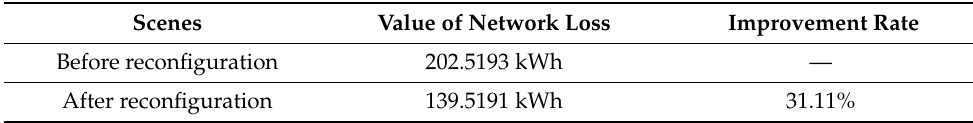
Table 3. Switch action before and after